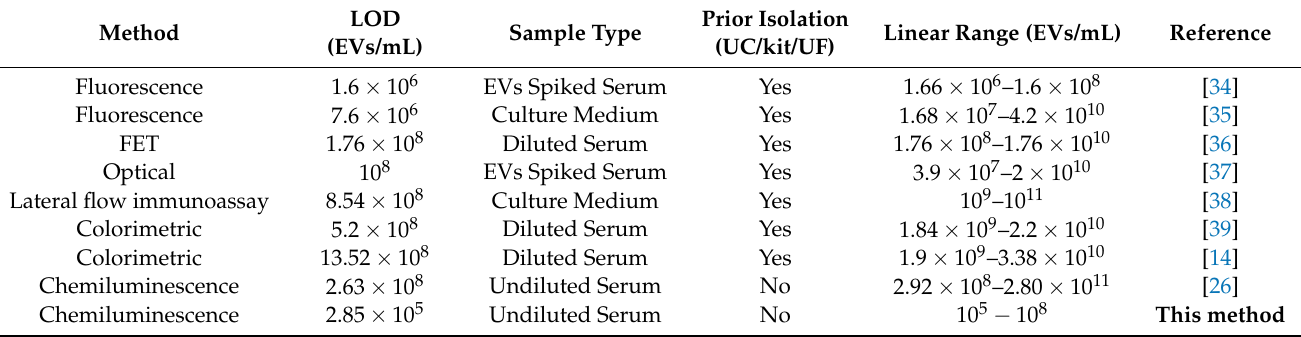
Table 1. Comparison with contemporary